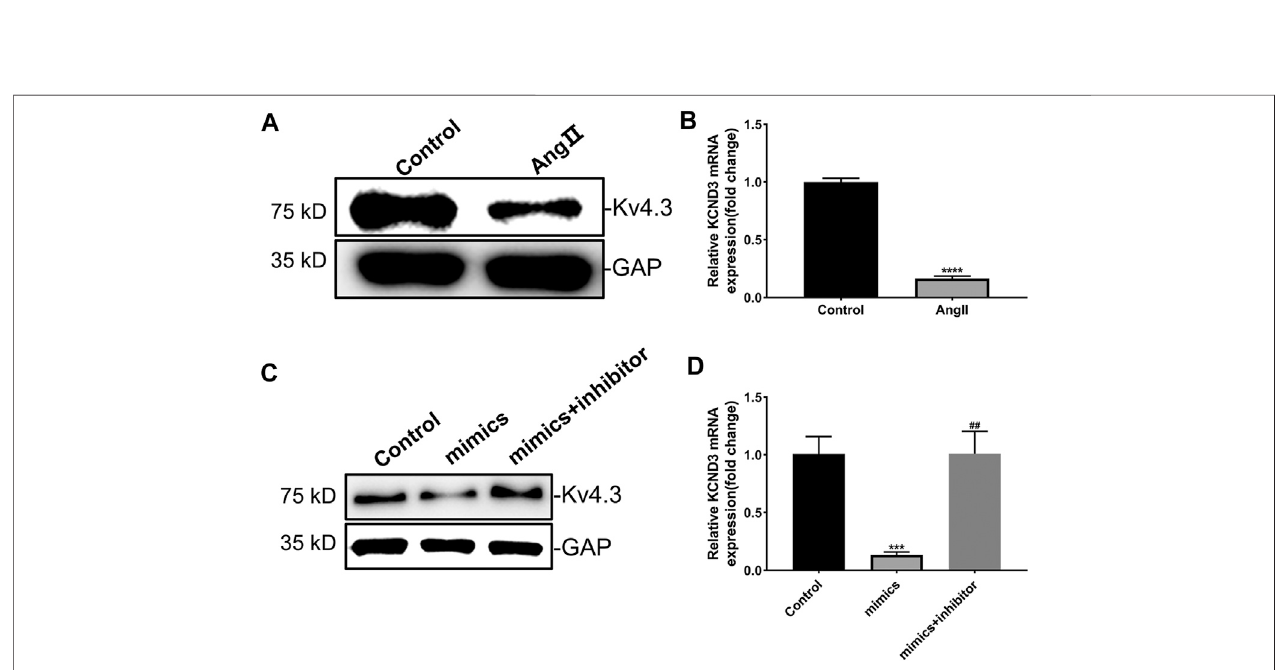
FIGURE 4 | MiR-27a-3p negatively regulates the expression of Kv4.3 in rat ventricular cardiomyocytes. (A – B) The expressions of Kv4.3 channel protein and KCND3 gene were down-regulated in Ang II-induced cardiomyocyte hypertrophy. (C – D) MiR-27a-3p-inhibitor can abrogate the changes in the expression of KCND3/ Kv4.3 induced by miR-27a-3p-mimics. All the values are the mean of three independent experiments ( n (cid:2) 3). **** p < 0.0001, *** p < 0.001 vs. control, ## p < 0.01 vs. mimics.